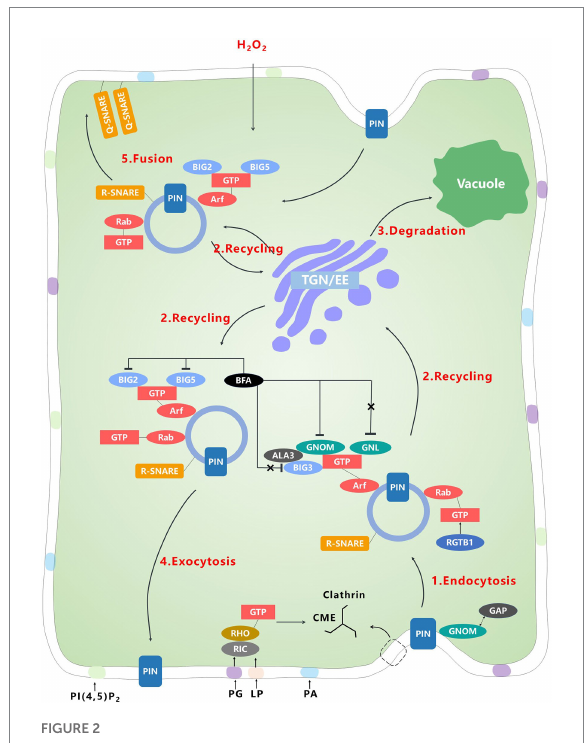
FIGURE 2 PINs can be recycled or degraded through endocytosis, subcellular trafficking and membrane fusion. In endocytosis, clathrin mediates the formation of vesicles. The PINs are then transported in the endosomal vesicles, in which many Arf and Rab proteins influence the destination of the PINs. These Arf and Rab proteins are further regulated by GEF and GAP, including GNOM, a PINs-specific AEF-GEF. Finally, the vesicles fuse to the destination membrane, regulated by SNARE. In addition, lipids are involved in the binding of these membrane-associated proteins. Notably, among these factors that may affect the polarity of PINs, only GNOM is primarily involved in the recycling basal